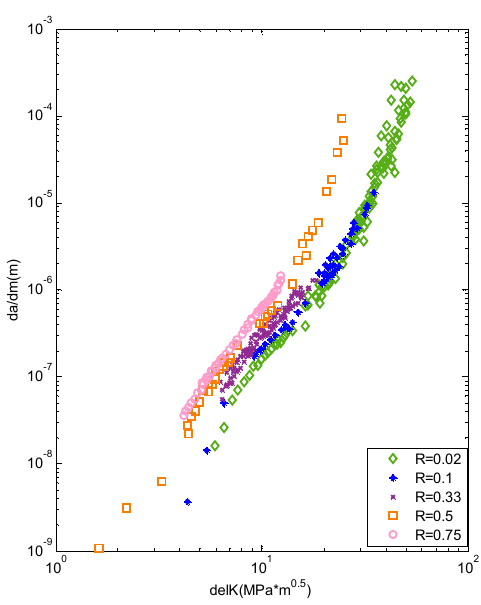
Figure 3. The experimental data of Al7075-T6.